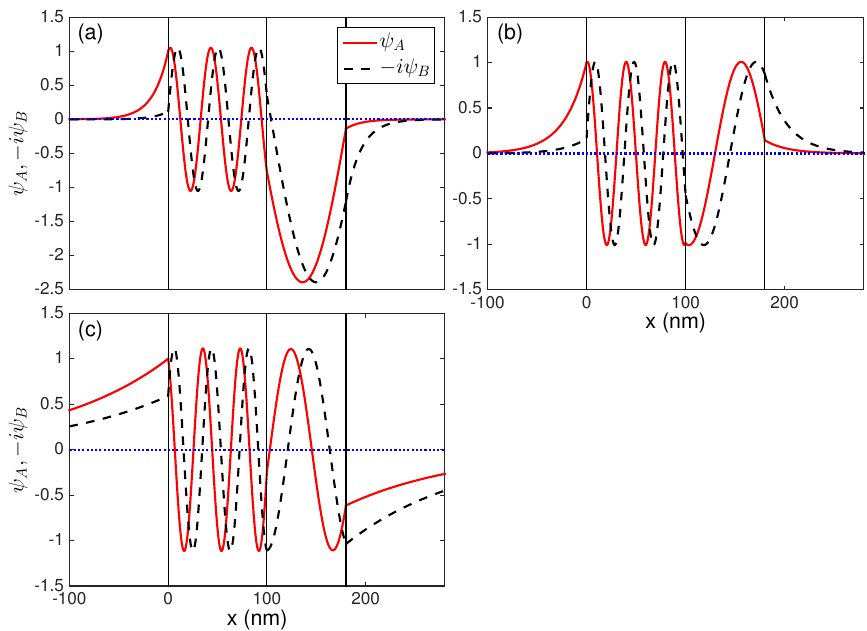
Figure 9. The wave function Ψ A (solid) and − i Ψ B (dashed) of guided modes as a function of distance corresponding to the intersections in Figure 7b: ( a ) k 2 x h 1 = 15.2675, θ = 23.8914 o ; ( b ) k 2 x h 1 = 16.0201,